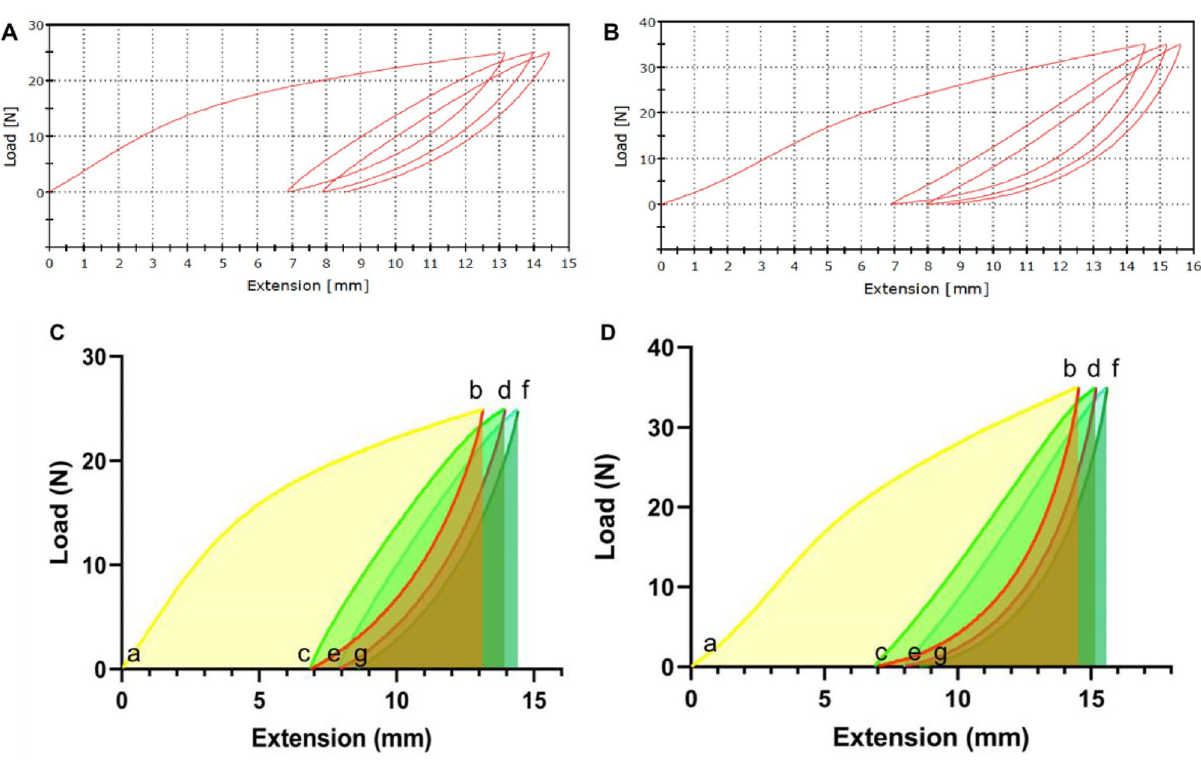
Figure 12. ( A ) Surgical and ( B ) FFP2 experimental hysteresis plots. ( C – D ) Simulation of the area under the curve (unloading-loading cycles) for ( C ) surgical and ( D ) FFP2 face masks. [Area Unit: N x mm = mJ